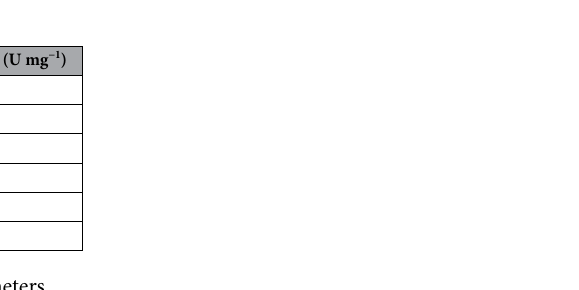
Table 1. Michaelis–Menten analysis